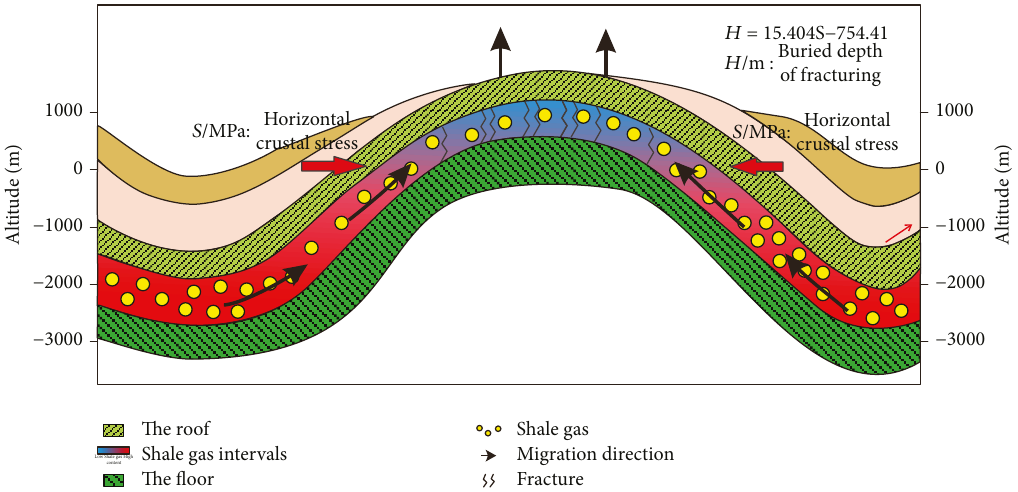
Figure 11: Accumulation model of marine shale gas in